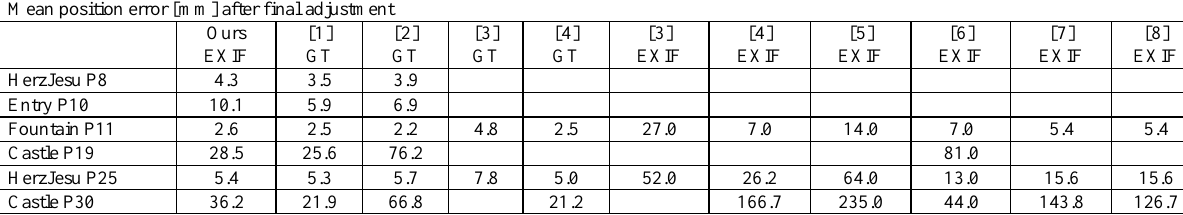
Table 4. Comparison of mean position errors after final bundle adjustment: [1] Moulon et al., 2013; [2] Olsson & Enqvist, 2011 as reported by [1]; [3] Arie-Nachimson et al., 2012; [4] Cui et al., 2015, L 1 ; [5] Jiang et al., 2013; [6] Reich & Heipke, 2016, TE-SI; [7] Chen et al., 2016; [8] Gherardi et al., 2010 as reported by